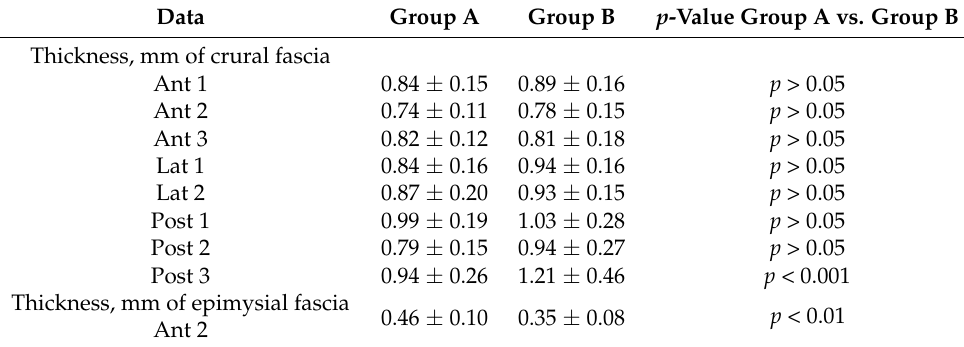
Table 2. Ultrasound measurements of crural fascia in both groups.